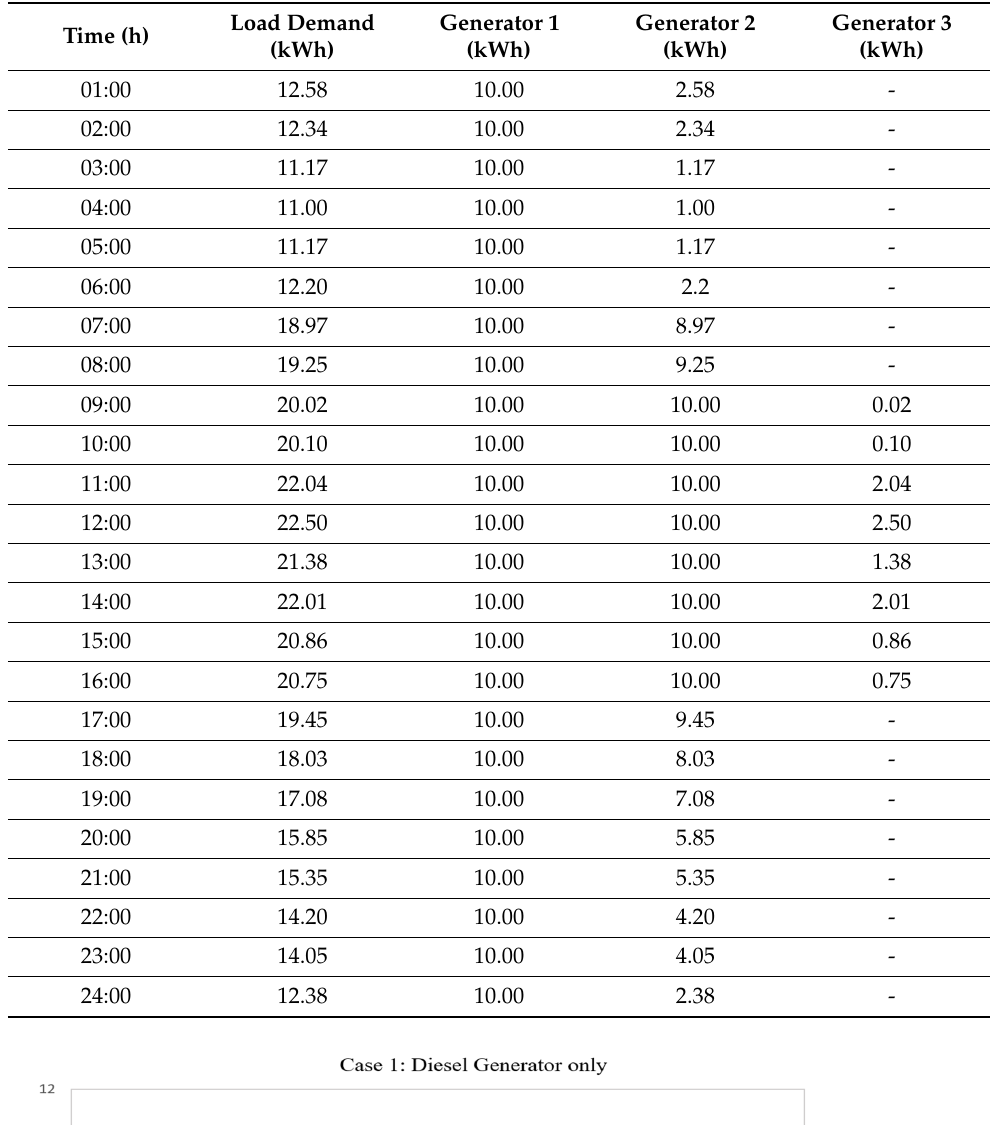
Table 4. Optimal power output for Case 1.